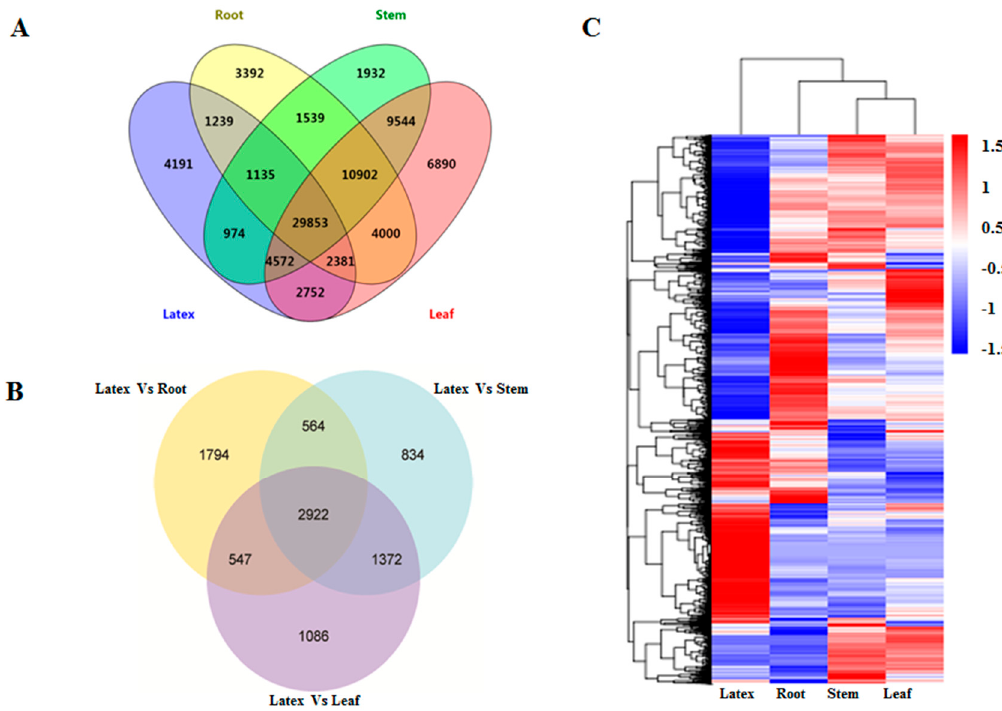
Figure 3. Expression analysis of the E. tirucalli unigenes. ( A ) Venn diagram analysis for the unigenes with their Fragments Per Kilobase Million (FPKM) values above 0.3 in different tissues; ( B ) Differentially Expressed Genes (DEG) analysis between tissues: latex vs. root, latex vs. stem and latex vs. leaf; ( C ) Heatmap analysis showing the expression pattern of DEGs in different tissues. Table 3. KEGG pathway enrichment analysis of DEGs between latex and the other tissues. To verify the reliability of DEGs identified by the FPKM method, 18 DEGs involved in the sterol biosynthesis were selected and their gene expression levels in the root, stem and leaf tissues were Pathway Term Pathway Term Pathway Term monitored by RT-qPCR analysis. As shown in Figure S6, the gene expression patterns for 15 DEGs Number Number Number Latex vs. Leaf Latex vs. Root Latex vs. (except for MVD , HDR , and EtOSC2 ) matched the results calculated by the FPKM method based on the transcriptome, suggesting that the FPKM method was reliable for gene expression analysis.